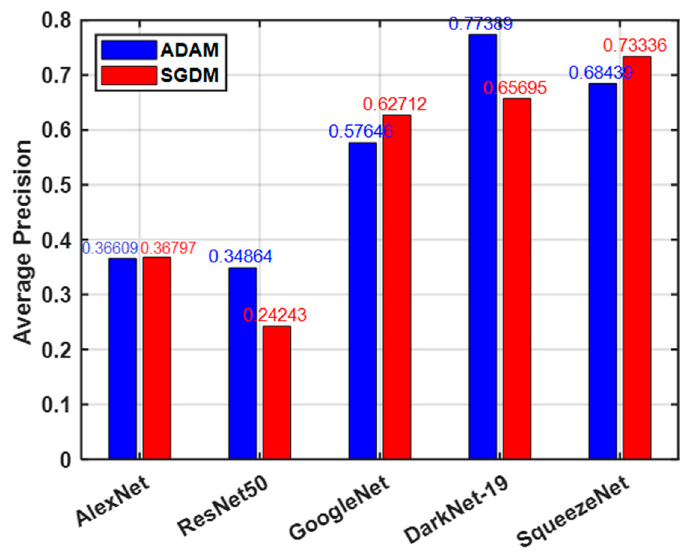
Figure 10. Average precision according to feature extraction networks and optimizers.